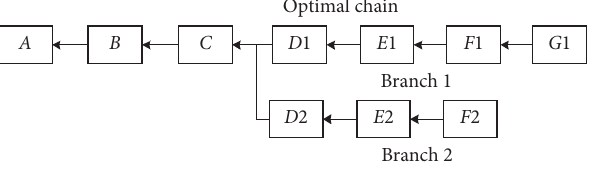
Figure 6: Longest chain rule.